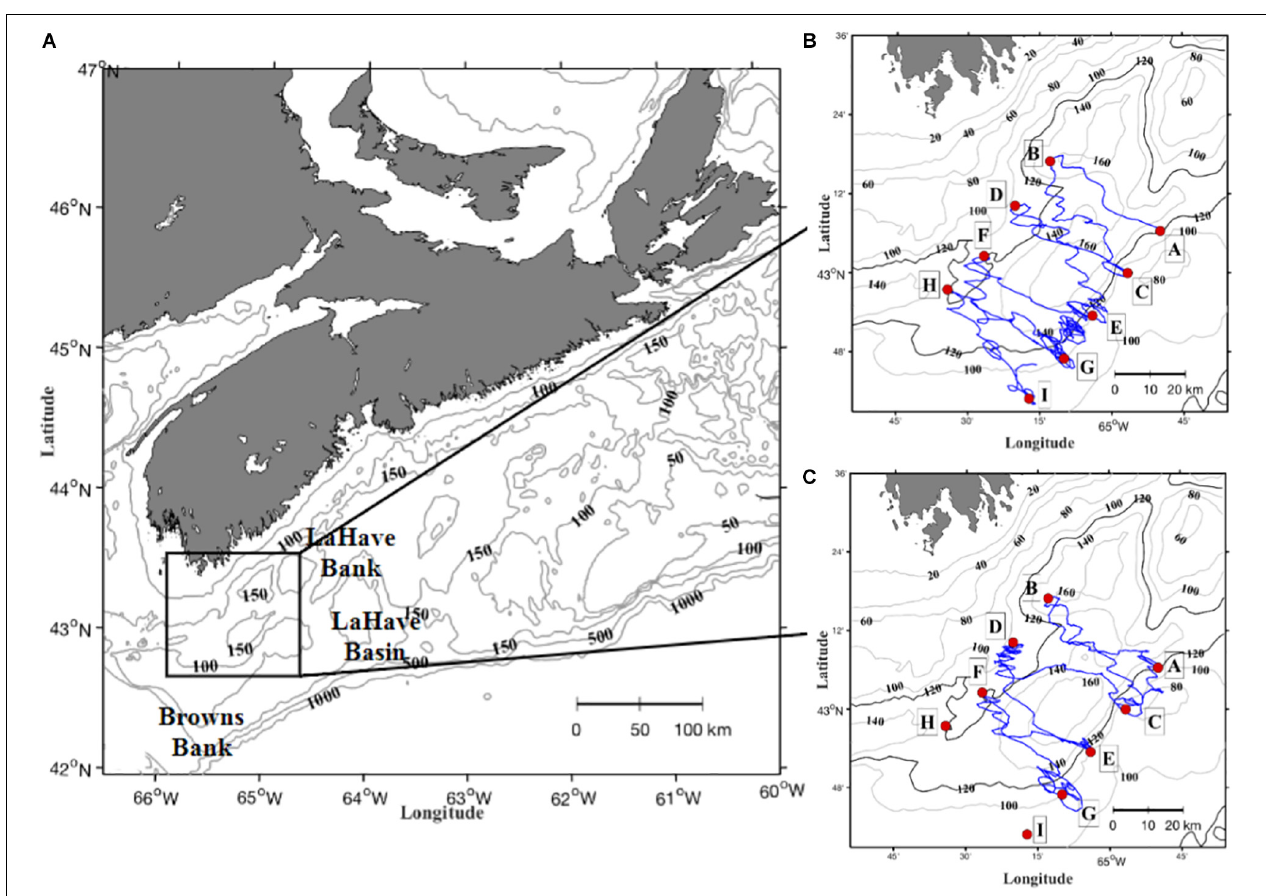
FIGURE 1 | Location of Roseway Basin on the Scotian Shelf (A) , and detailed basin bathymetry with survey waypoints (A-I; red circles) and realized glider track for first (B) and second (C) glider transits. The 120 m isobath is shown in bold in (B,C) to indicate the boundary of the basin margin or